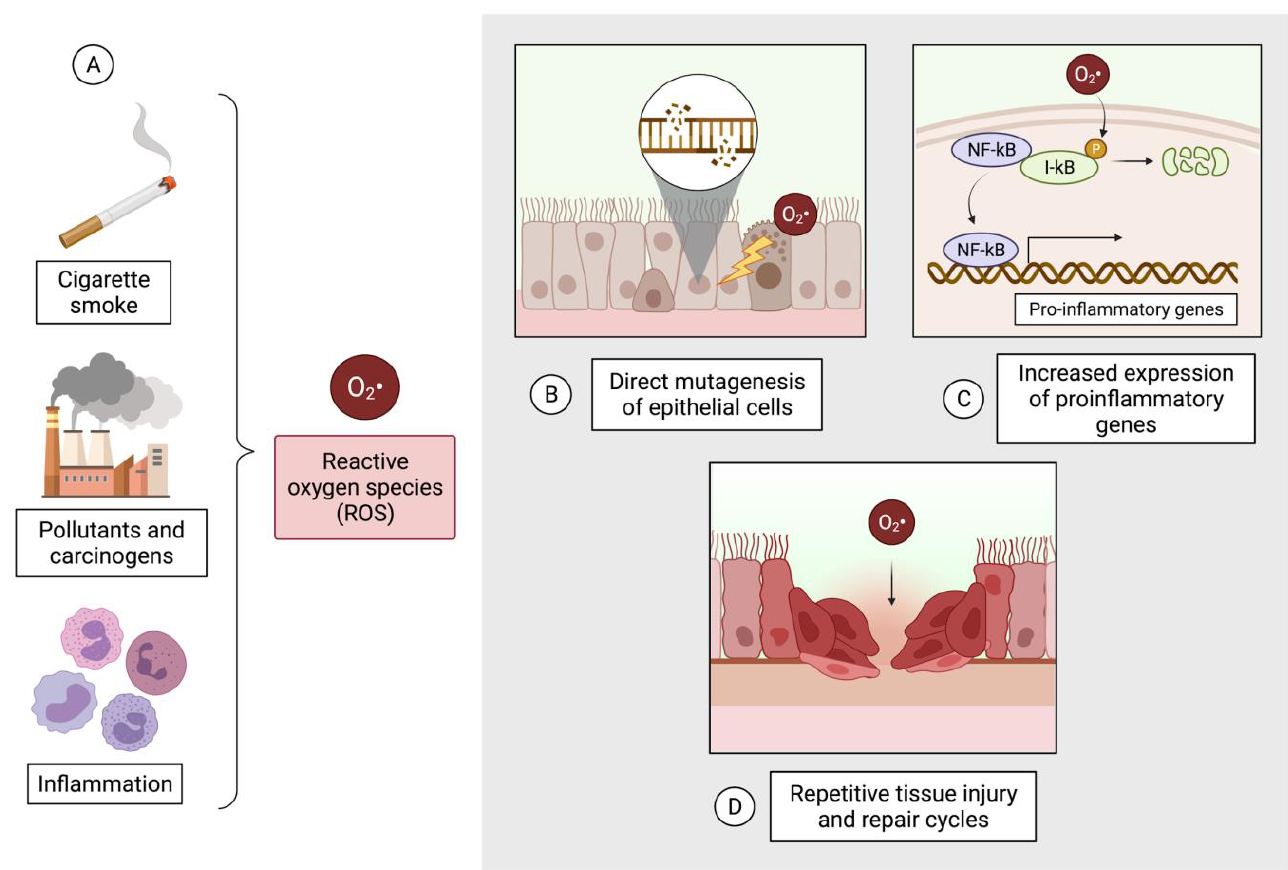
Figure 3. Oxidative stress is a common underlying mechanism in the pathogenesis of COPD and lung cancer. ( A ) It is generated in the presence of inflammation, tobacco smoke, pollutants, and carcinogens. ( B ) Reactive oxygen species (ROS) directly causes DNA damage in lung epithelial cells. ( C ) ROS increases the expression of pro-inflammatory genes in a NK-kB-dependent manner. ( D ) Repeated cycles of tissue injury and repair occur due to damage from ROS, which involves the process of epithelial-mesenchymal transition.